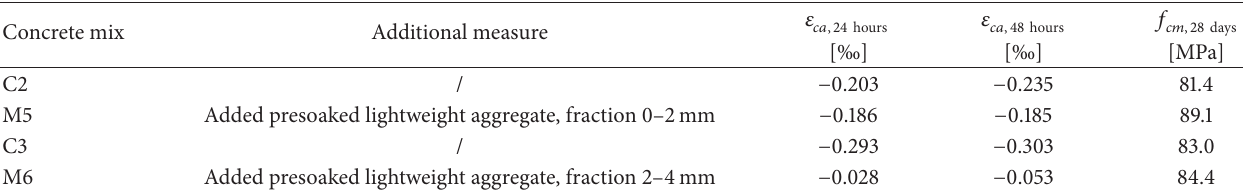
Table 8: Comparison of the autogenous shrinkage of 24- and 48-hour-old concretes, containing natural crushed stone aggregate or with added presoaked lightweight aggregate, and their associated 28-day compressive